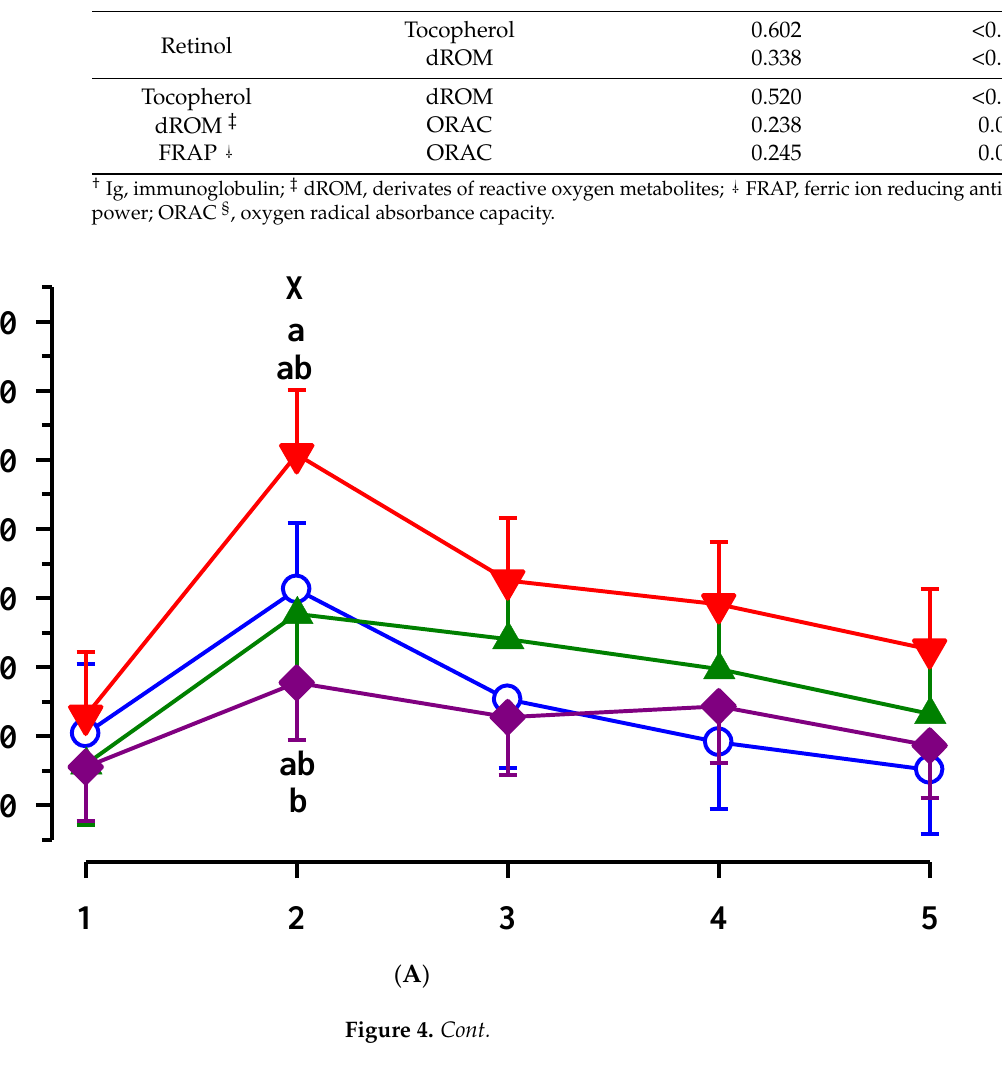
Table 1. Experimental design and animals.